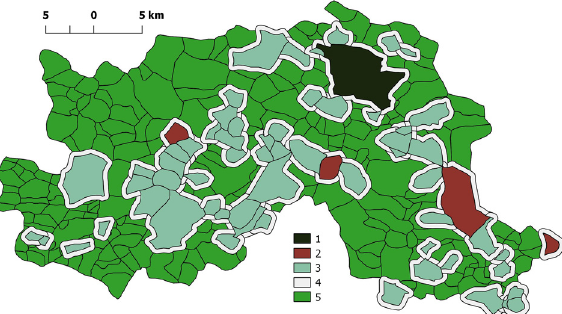
Fig. 3. Residential area analysis for Gurugram district.